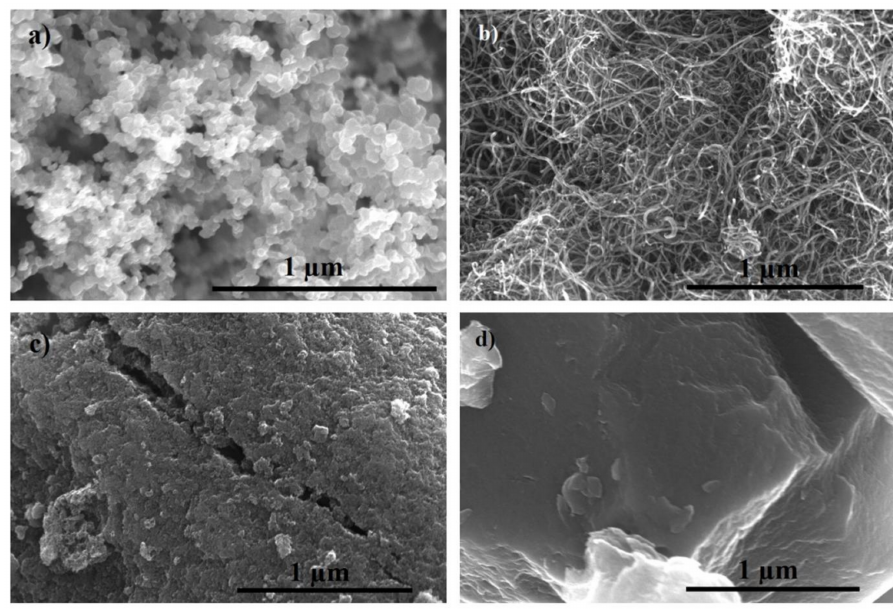
Figure 3. SEM-Images from ( a ) aCB; ( b ) aCNTs; ( c ) aAC1 and ( d ) aAC2.